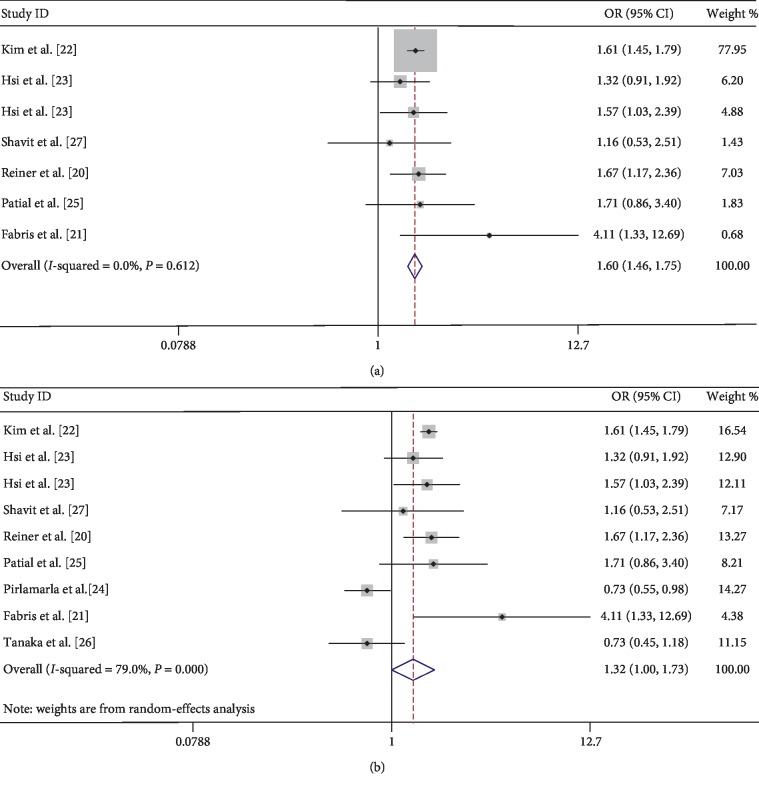
Forest of comparison: urolithiasis versus without urolithiasis and event: arteriosclerosis. OR value and CI without adjusting potential confounding factors. (a) Removal of heterogeneous sources: Pirlamarla et al. [24]. (b) Without removal of heterogeneous sources: Pirlamarla et al. [24]. OR: odds ratio; CI: confidence interval.